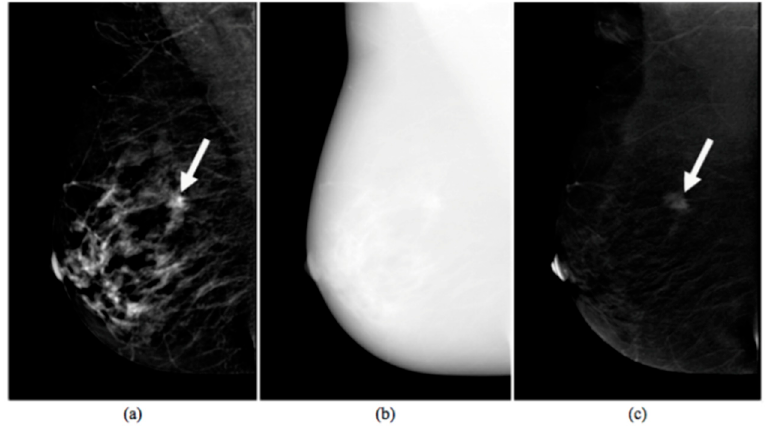
Figure 1. Images produced by contrast-enhanced spectral mammography (CESM instrumenta- tion). Typical example of low energy ( a ), high energy ( b ), and recombined ( c ) images [17]. The white arrow points out a suspicious lesion.